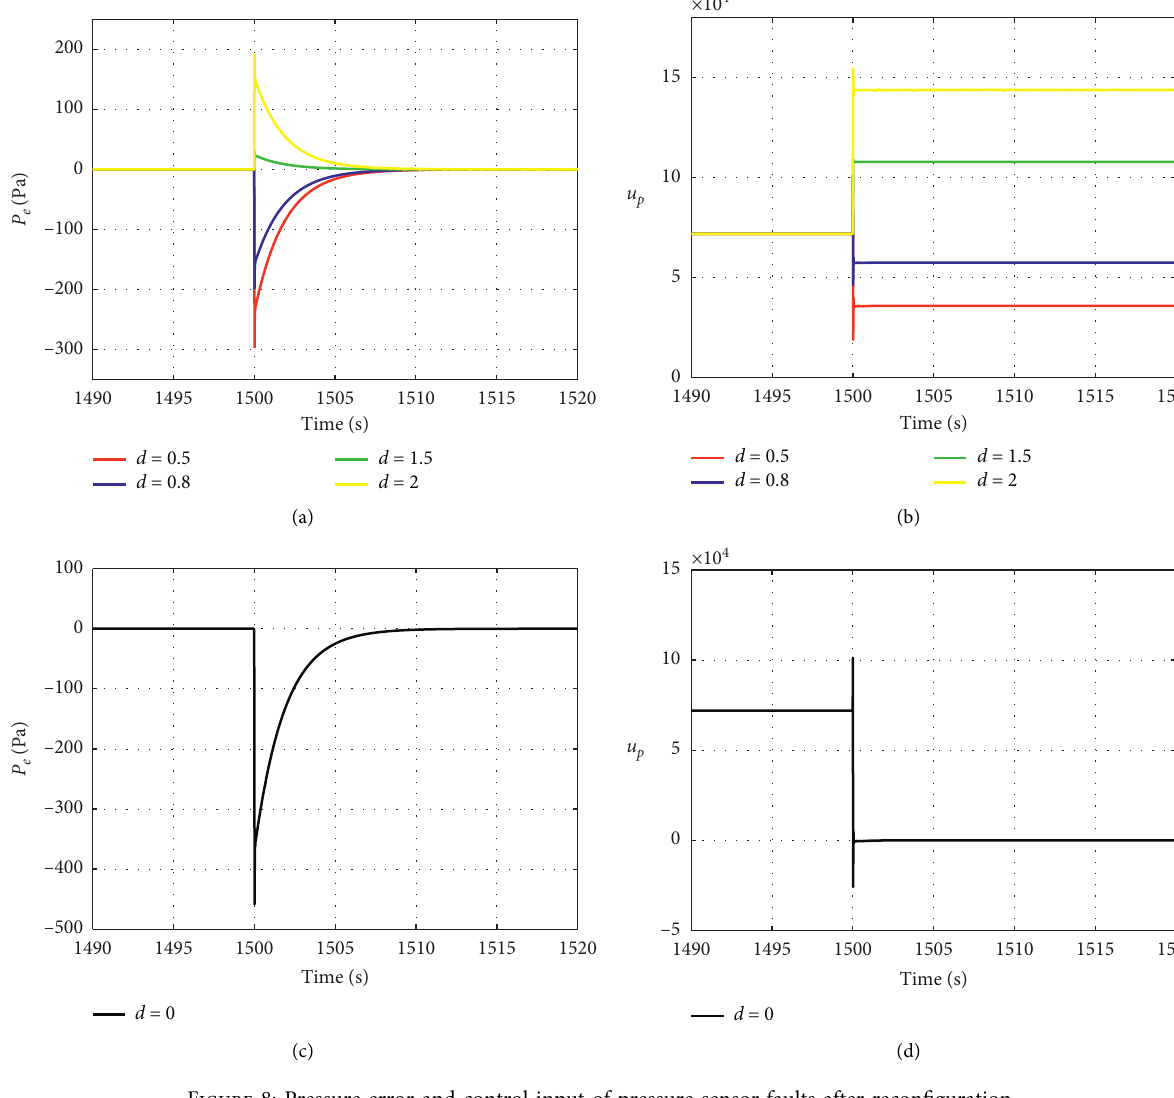
Figure 8: Pressure error and control input of pressure sensor faults after